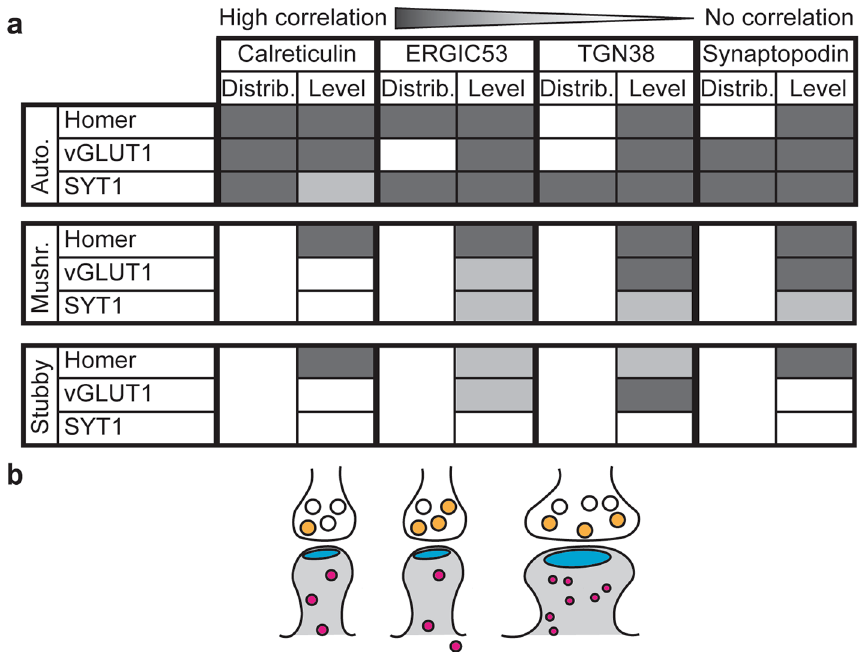
Figure 6. Summary of effects and proposed model. ( a ) Summary of the correlation between the elements of the secretory pathway (in terms of distribution and levels), and post-synaptic strength (homer), pre- synaptic strength (vGLUT1), or pre-synaptic activity (SYT1) for the different analysis performed (automatic analysis of all synapses, or manual analyses of mushroom spines and stubby spines). The different shades of grey correspond to high correlation/influence (darker grey), or less (light grey) to no (white) correlation/ influence. ( b ) Model for the effect of synaptic strength and activity on the elements of the secretory pathway. Increased activity initially mobilizes the locally available resources, whose availability increases to support spine enlargement and